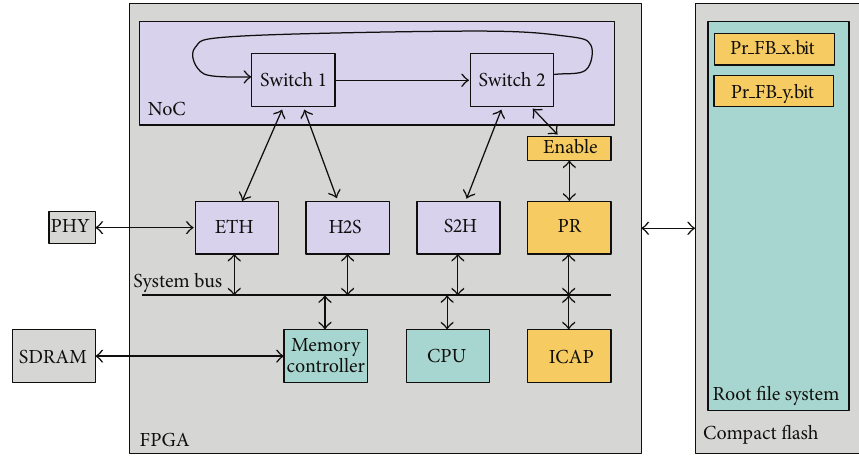
Figure 4: EmbedNet FPGA